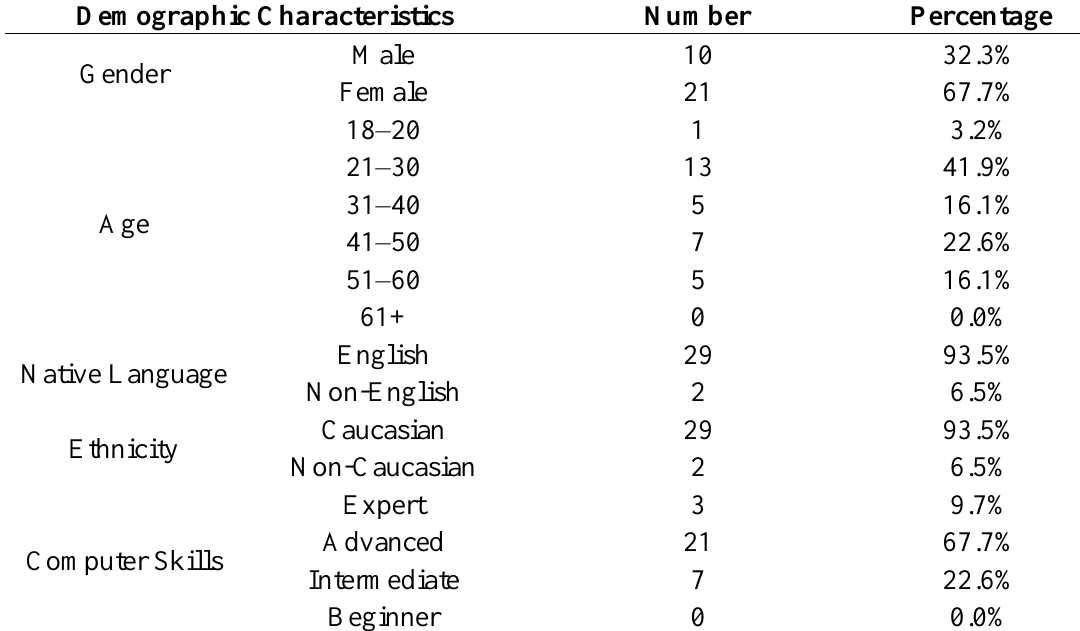
Table 1. Characteristics of Participants (N =